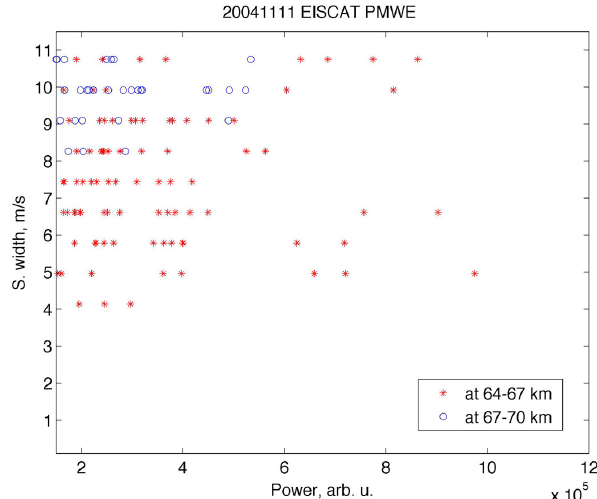
Fig. 5. Histograms of half-maximum half-width (HMHW) of power spectra at each altitude inside (left panel) and outside (right panel) PMWE measured by the EISCAT VHF radar on 11 November 2004. Colour indicates number of cases when HMHW has a value lying in the particular spectral width bin. Profiles of median HMHWs are indicated in magenta.